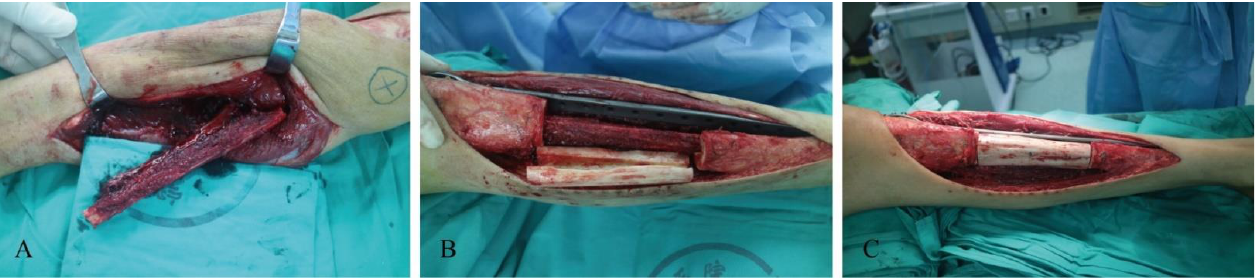
Figure 2. Photographs of the main procedures of reconstruction in the tibia. ( A ) Preparation of the ipsilateral fibular graft. ( B ) Replantation of devitalized autograft. ( C ) Assembly and fixation of devitalized autograft and fibular graft.